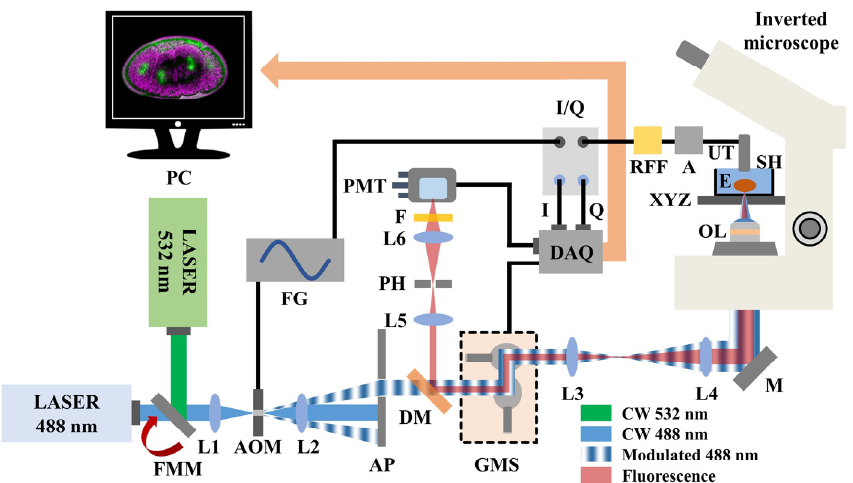
Figure 1. Schematic illustration of the hybrid microscopy system. Abbreviations: FMM, Flip mount mirror; L(1–6), Lenses; AOM, Acousto-optic modulator; FG, Function generator; AP, Aperture; DM, Dichroic mirror; GMS, Galvanometric mirror scanner; M, Broadband mirror; OL, Objective lens; E, Embryo; XYZ, Microscope’s positioning and focusing system; SH, Sample holder; UT, Ultrasonic transducer; A, RF amplifier; RFF, Bandpass RF filter; I/Q, Demodulator; DAQ, Data acquisition card; PMT, Photomultiplier tube; F, Longpass optical filter; PH, Pinhole; PC, Computer.